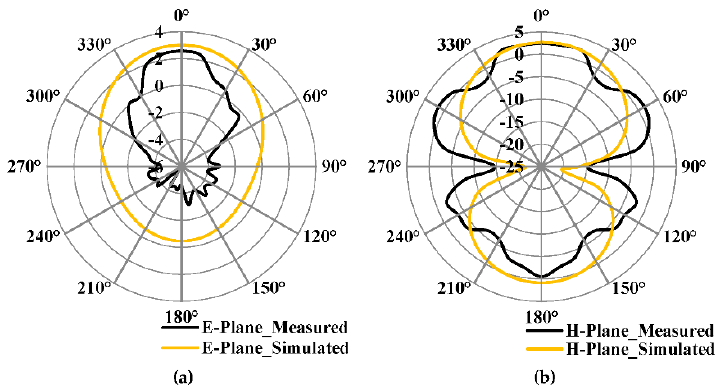
Figure 18. Simulated and Measured radiation pattern of the proposed antenna with 3 × 3 cross-slot MTM structure etched on the ground plane ( a ) E-Plane ( b ) H-Plane.